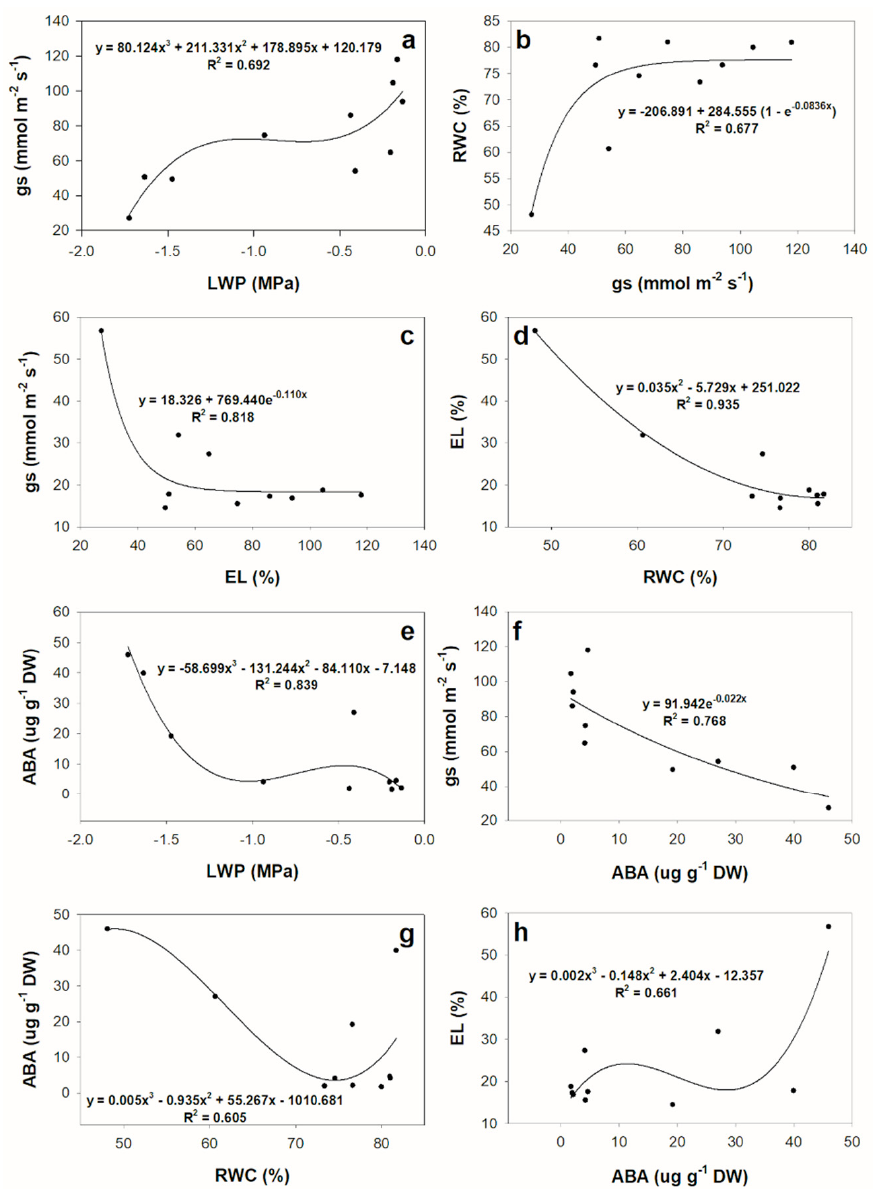
Figure 4. ( a ) Relationship between leaf water potential (LWP) and stomatal conductance (gs); ( b ) relationship between gs and relative water content (RWC); ( c ) relationship between electrolyte leakage (EL) and gs; ( d ) relationship between RWC and EL; ( e ) relationship between LWP and abscisic acid (ABA) content; ( f ) relationship between ABA and gs; ( g ) relationship between RWC and ABA; finally, ( h ) relationship between EL and ABA. Each value is a single measurement.